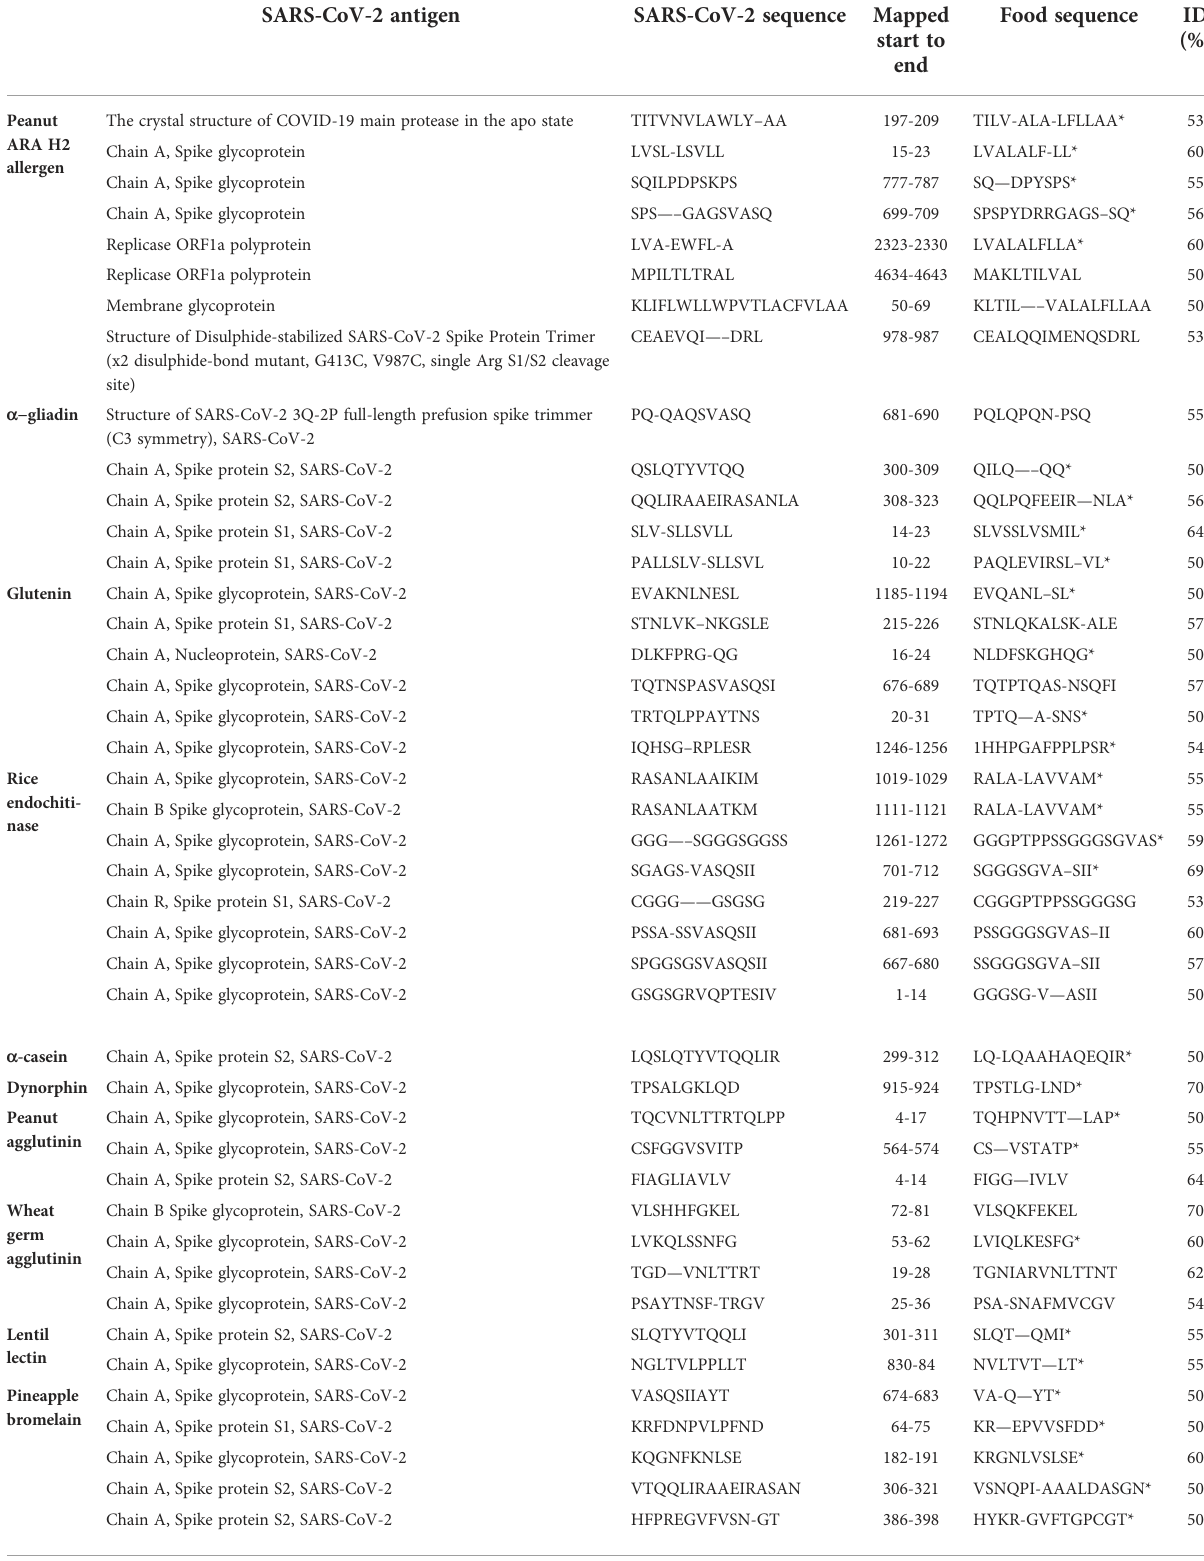
TABLE 2 Potential cross-reactive epitopes between SARS-CoV-2 proteins and food